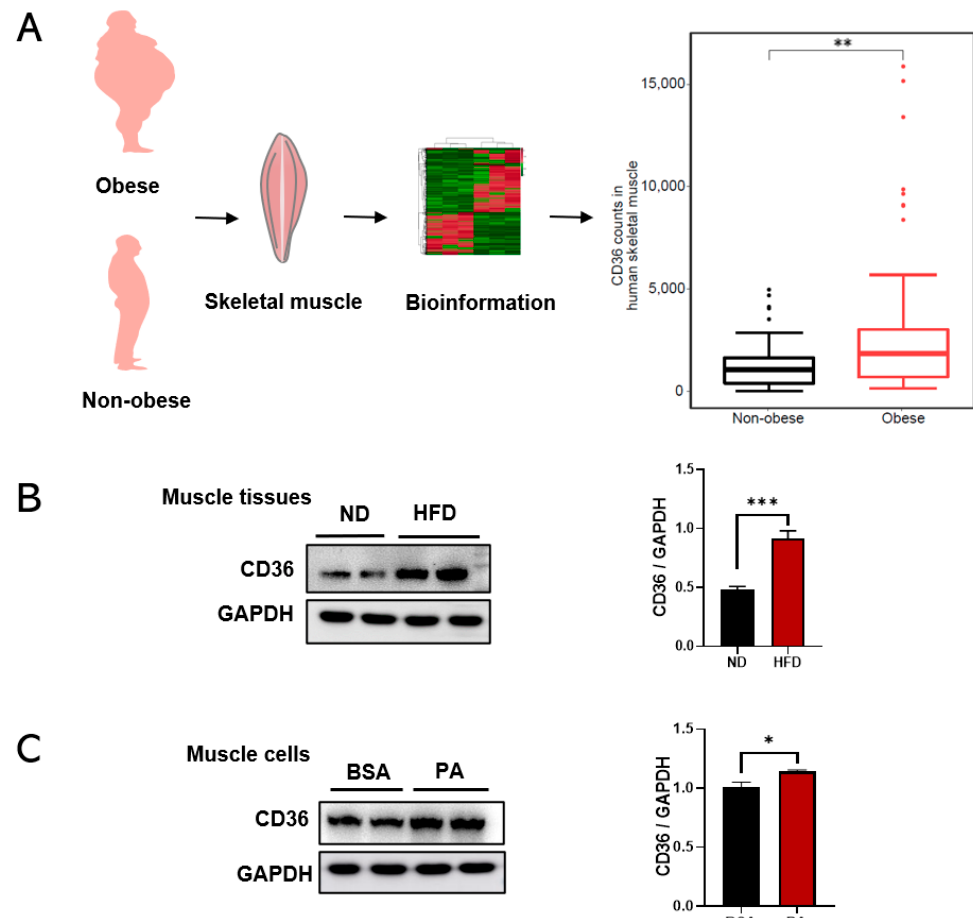
Figure 1. The expression levels of CD36 are upregulated in the skeletal muscle tissues of obese humans and mice in vivo and in vitro . ( A ) Bioinformatics analysis of CD36 counts in human skeletal muscles in the obese and non-obese groups. ( B ) Western blot analysis and quantification of CD36 protein expression in the skeletal muscles of HFD-fed mice. ( C ) Western blot analysis and quantification of CD36 protein expression in skeletal muscles cells under PA stimulation. CD36 expression was normalized to that of the GAPDH gene. Values are presented as the mean ± SEM of three independent experiments. * p < 0.05, ** p < 0.01, *** p < 0.001 versus the siCont group.